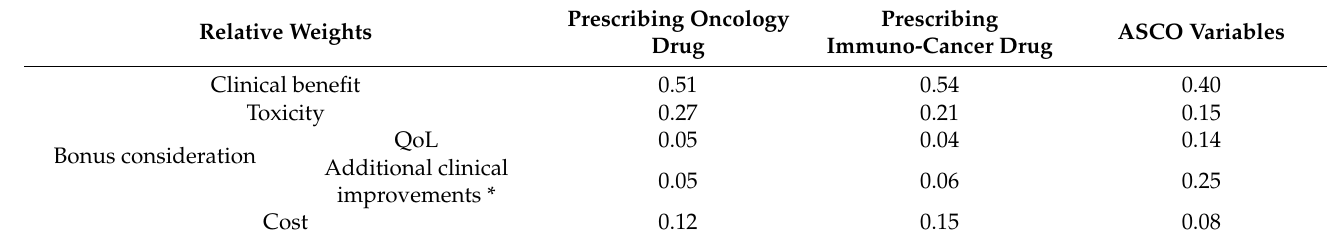
Table 2. Relative weights by analytic hierarchy process